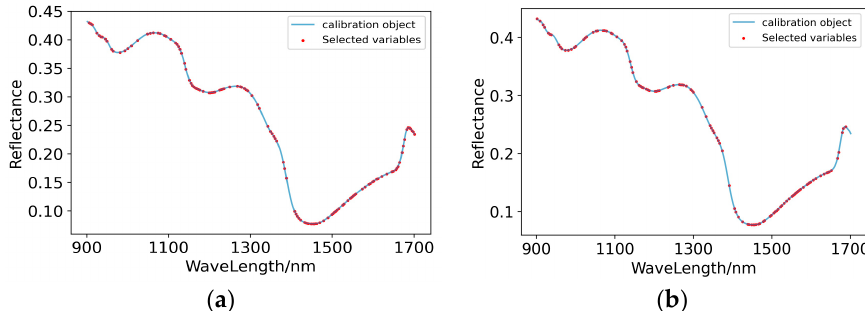
Figure 6. Characteristic wavelengths’ distribution of prediction models for the content of calcium in pear pulp. ( a ) Raw-GA-PLSR; ( b ) SG-GA-PLSR. (1) Modelling of characteristic wavelengths Table 3. Modelling prediction results of the content of calcium in pear pulp based on the selected characteristic wavelengths by using GA.